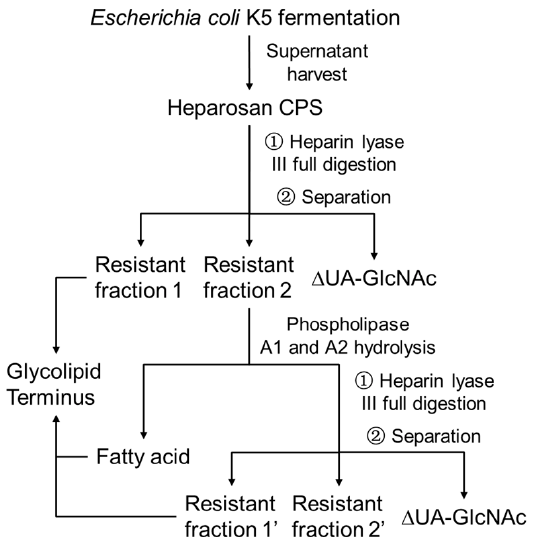
Scheme 1. Flow chart of the Escherichia coli K5 heparosan capsular polysaccharide (CPS) processing and the resulting fractions for glycolipid terminus analysis.